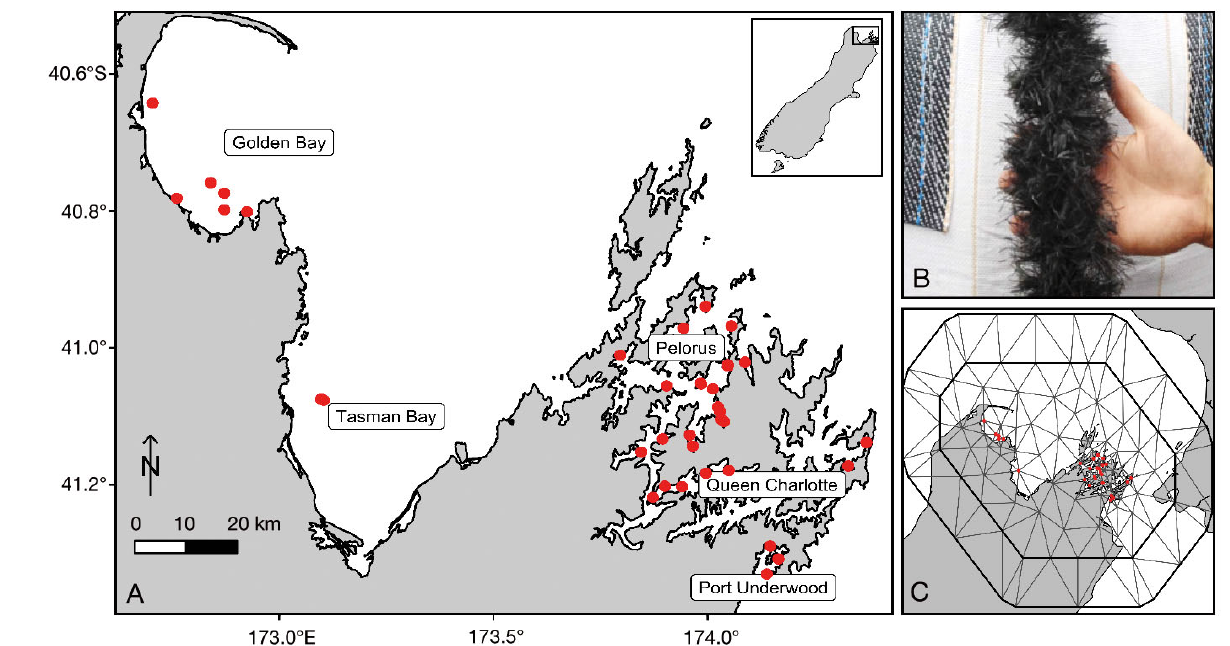
Fig. 1. (A) Study area, in relation to New Zealand’s South Island (inset), showing the main sub-regions. (B) ‘Xmas tree’ rope used in collectors to sample Mytilus spat. (C) Mesh pattern used to calculate the effect of geographical location (Gaussian random field) and the location of the study sites (red